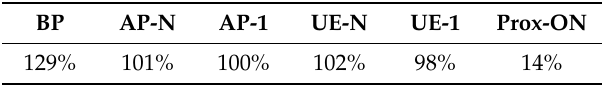
Table 2. The average energy efficiency improvement percentages of the proposed algorithms to the baseline. Prox-ON,